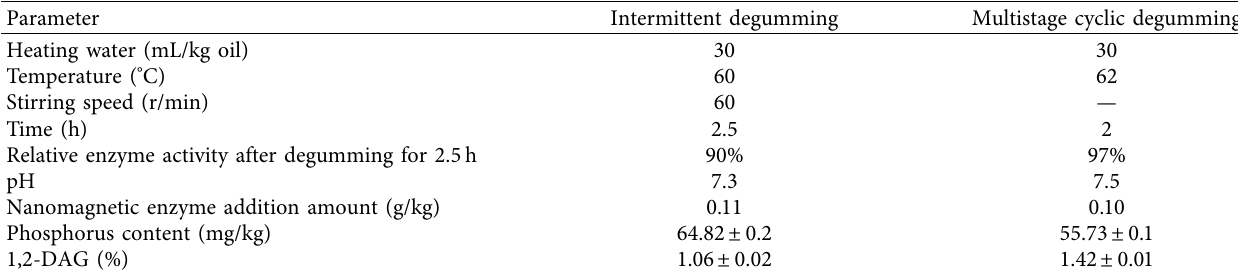
Table 3: Degumming effect of nanomagnetic enzyme